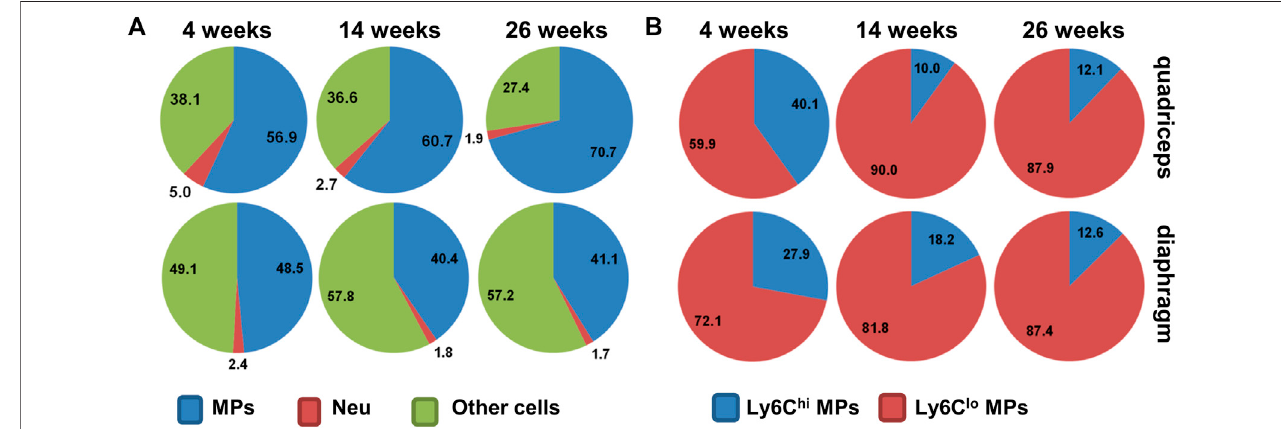
FIGURE 2 | (A) Pie chart showing percentages of macrophages (MPs), neutrophils (Neu), and other cells among intramuscular CD45 + cells in mdx 5cv mice at different ages. (B) Pie chart showing percentages of Ly6C hi and Ly6C lo subpopulations among intramuscular macrophages in mdx 5cv mice at different ages.